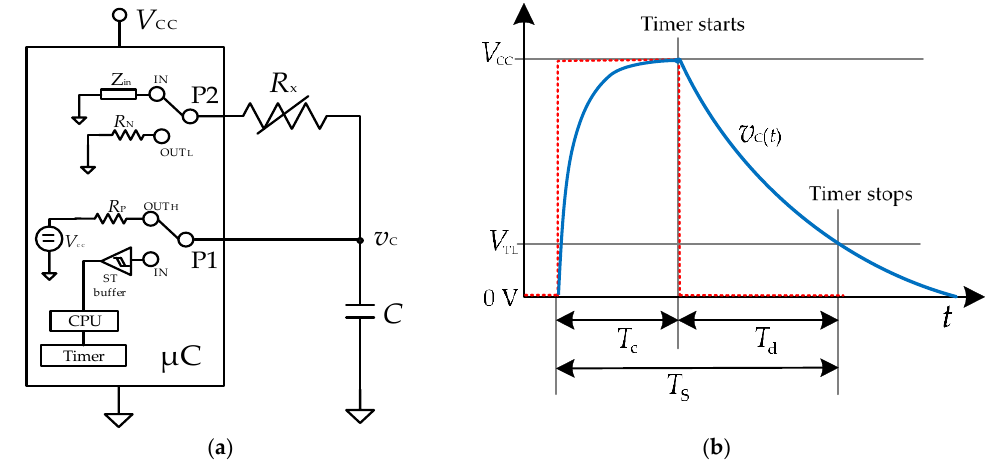
Figure 2. ( a ) DIC measuring a resistive sensor; ( b ) Voltage across C in ( a ) during the charge-discharge process.